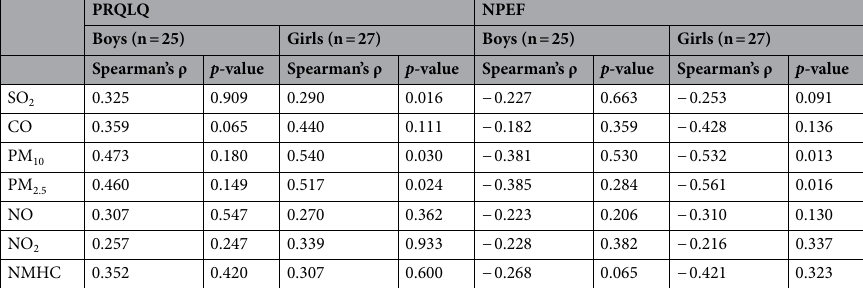
Table 4. Obese AR children, correlation between PRQLQ score, NPEF rates and mean air pollutant concentrations (within 7 days before the tests). Spearman’s ρ: Spearman’s rank correlation coefficient. p -value: adjust for age, parental occupation, second-hand smoke exposure, combined with asthma, mean ambient temperature and relative humidity within 7 days before the test.